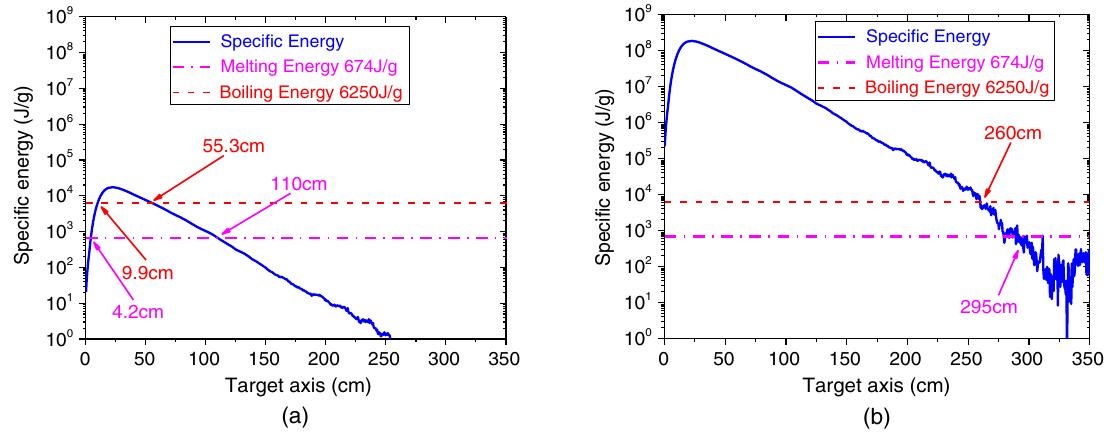
FIG. 10. Specific energies of (a) one bunch with 1 . 0 × 10 11 protons and (b) one full FCC beam with 10600 bunches. The top energy of the FCC (50 TeV) is used. The beam size is 0.2